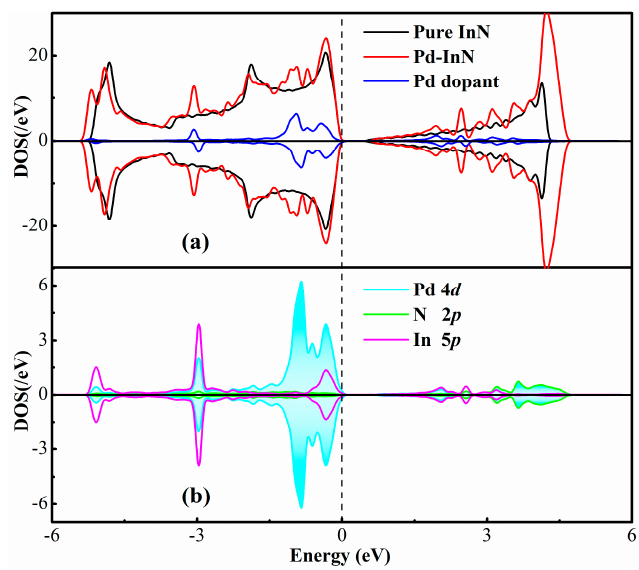
Figure 2. Total DOS ( a ) and partial DOS ( b ) of Pd-InN. The dash line is the Fermi level.